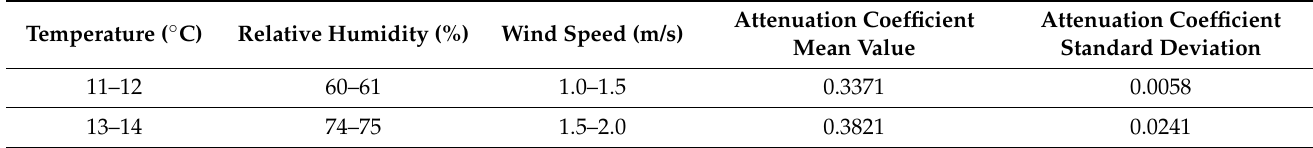
Table 7. Mean value and standard deviation of experimental attenuation